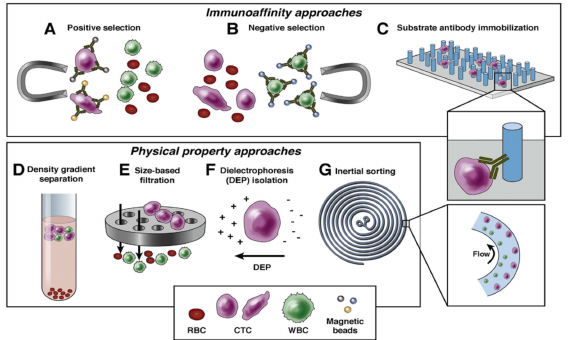
Figure 2. Biological and physical approaches of enrichment. Retrieved with permission from